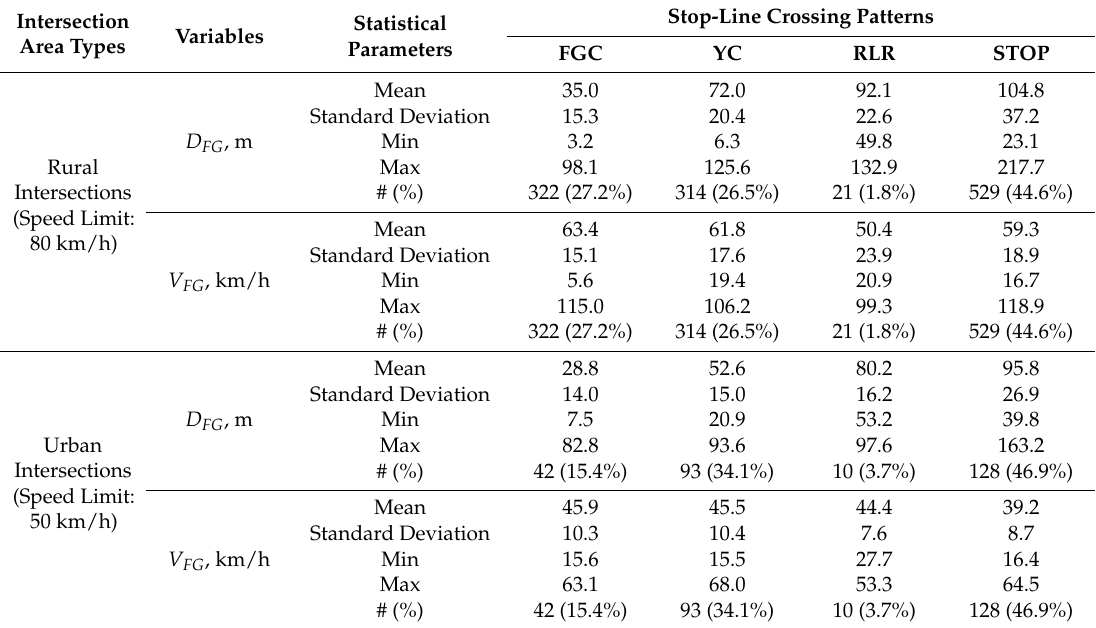
Table 2. Descriptive statistics of distances to the stop-line and speeds at the onset of FG for various stop-line crossing